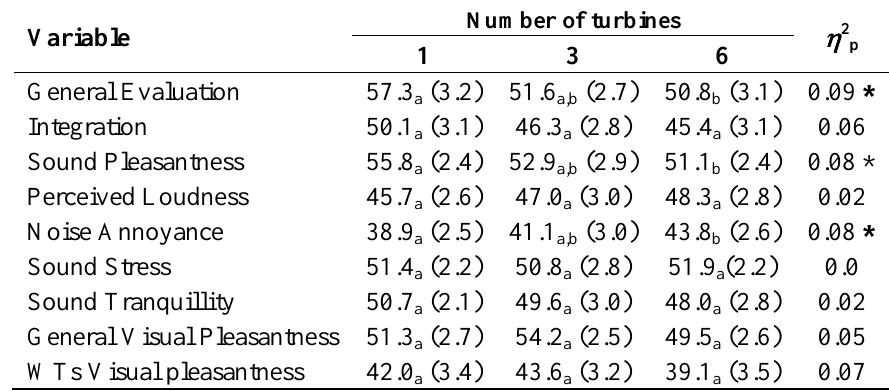
Table 5. Mean values (standard error) and effect size as a function of the Number of turbines.